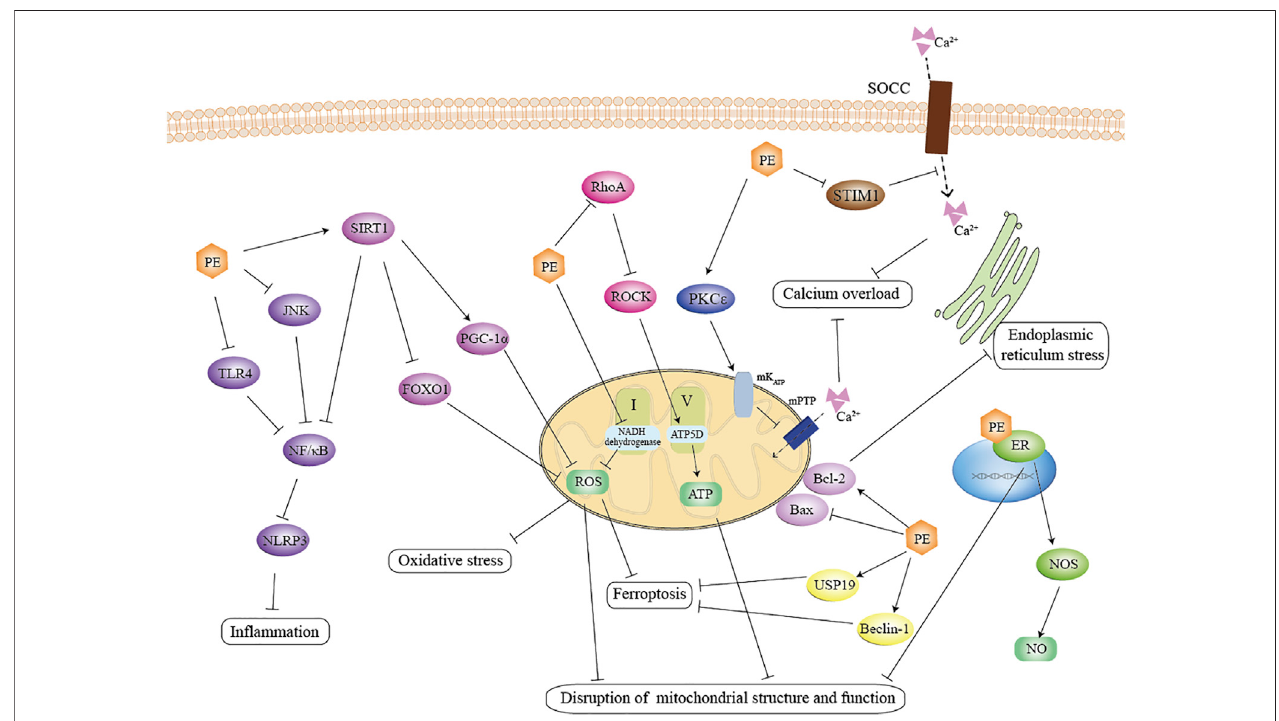
FIGURE 8 | Schematic representation of the anti-MIRI effect of PE. PE suppress the in fl ammation by inhibiting the TLR4-NF/ κ B and JNK- NF/ κ B signaling pathways,inhibitmitochondrialoxidativestressbyactivatingtheSIRT1pathway,andpromotedtheactivityofthemitochondrialcomplexbyinhibitingtheRohApathway. In addition, PE attenuated calcium overload via STIM1-mediated SOCE. Notably, PE not only maintained mitochondrial homeostasis through interaction with estrogen receptors, but also promoted NO production, which effectively exerted cardioprotective effects. TLR4: toll-like receptor four; JNK: JunNterminal kinase; NF/ κ B: nuclear factor- κ -gene binding; SIRT1: silent information regulator 1; FOXO1: forkhead box O; PGC-1 α : proliferator-activated receptor- γ coactlvator-1 α ; ROS: reactive oxygen species; ROCK: RhoA/Rho-associated coiled-coil containing protein kinase; PKC ε : protein kinase C; STIM1: stromal interacting molecule 1; SOCC: store- operated calcium channels; ER: estrogen receptor; NOS: nitric oxide synthase; USP19: ubiquity speci fi c peptidase